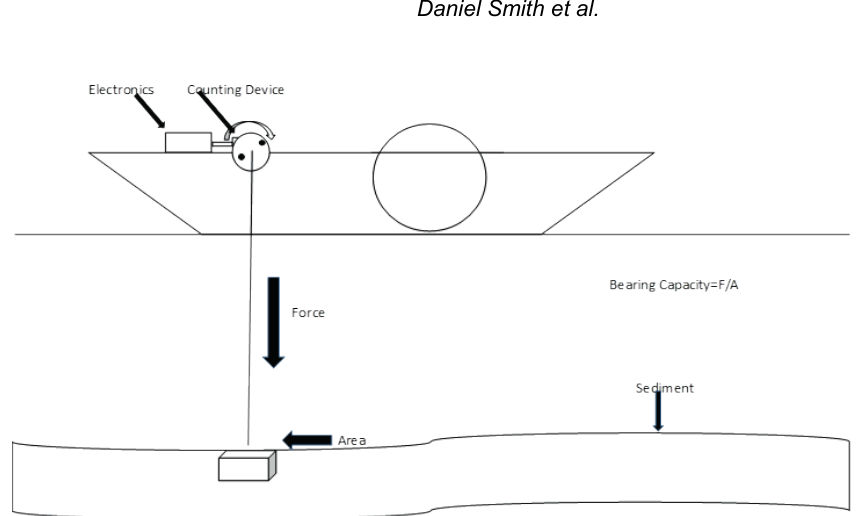
Fig. 1 Autonomous boat for sediment